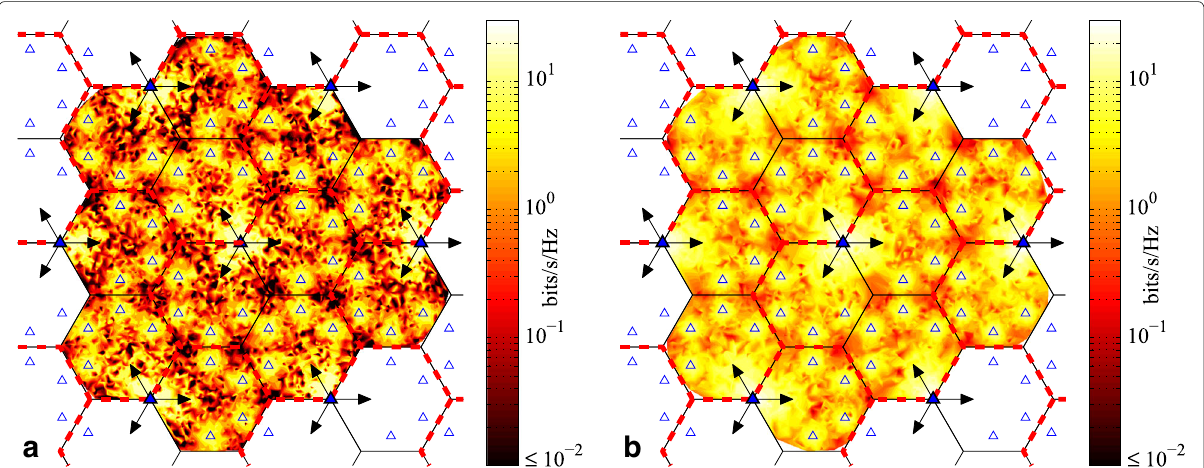
Fig. 10 Average achievable rate per user based on user position within cellular network, with MT scheduling for three-cell layout, using simulated annealing scheduling and SZF-DPC precoding; N macro = N pico = 2, M = 2, K c = 12. a Fixed clustering. b Rotating clustering ( T cl = 40)